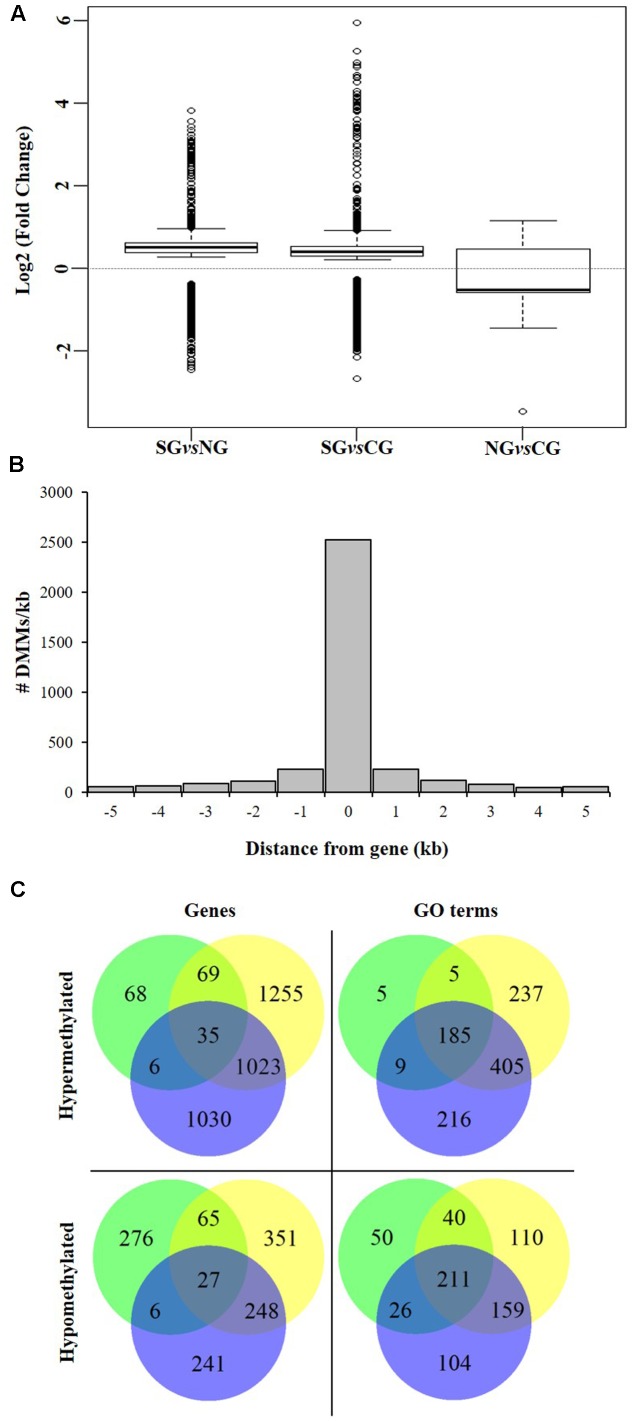
Analysis of DMGs and GO terms (DMGOs) among three wine sub-regions in Barossa Shiraz. Genes were considered differentially methylated if located within 5 kb of at least one DMM (FDR < 0.01). DMMs were generated using msGBS on nine plants per vineyard (Northern Grounds: four vineyards, Central Grounds: four vineyards, and Southern Grounds; three vineyards). (A) Directionality of methylation differences between regions. Boxplots show the distribution of the intensity of changes in DNA methylation level between regions, represented here as the fold-change (2 power log2FC) in read counts for a given msGBS markers between two regions. Median shows the direction of the methylation flux at a whole genome level in each region comparison (i.e., positive medians indicate a global increase in DNA methylation (hypermethylation) while negative medians indicate a global decrease in DNA methylation (hypomethylation) in the second region in the comparison (e.g., Northern Grounds is hypermethylated compared to Southern Grounds). (B) Distribution of 3598 region specific DMMs around genes. Columns –5 to –1 and 1 to 5 represents the number of DMMs per kb around V. vinifera genes. Column 0 indicates the number of DMMs within the coding sequence (i.e., between the transcription start and end sites) of V. vinifera genes. (C) Shared DMGs and DMGOs between regional comparisons. Venn diagrams show the number of unique and shared DMGs and DMGOs between each regional pairwise comparison (i.e., Blue: hyper/hypomethylated genes and GOs in Northern Grounds compared to Southern Grounds; Yellow: in Central Grounds compared to Southern Grounds; and Green: in Central Grounds compared to Northern Grounds).